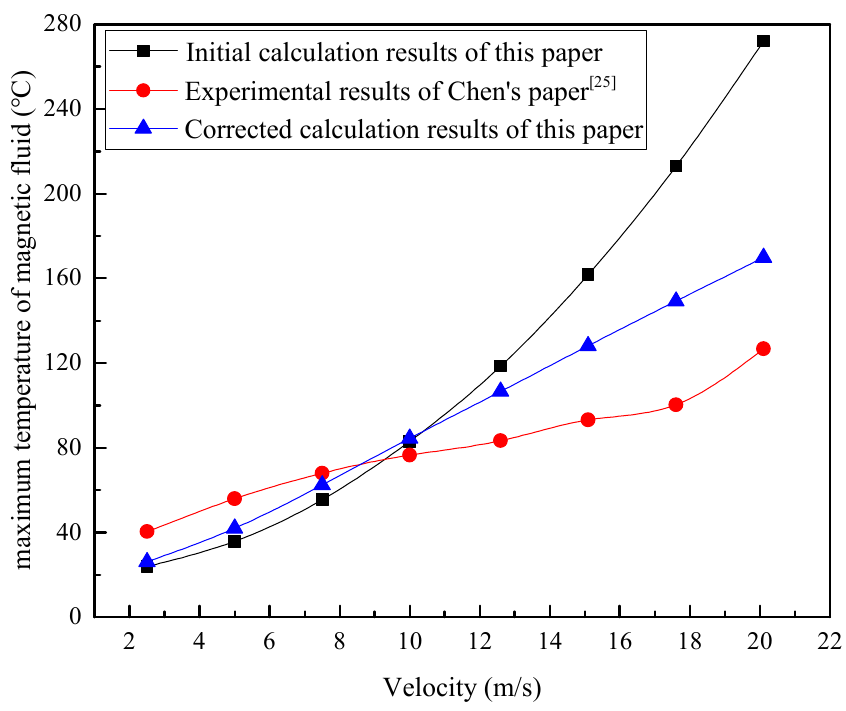
Figure 8. Maximum temperature of the diester-based magnetic fluid in the sealing gap at different linear velocities.